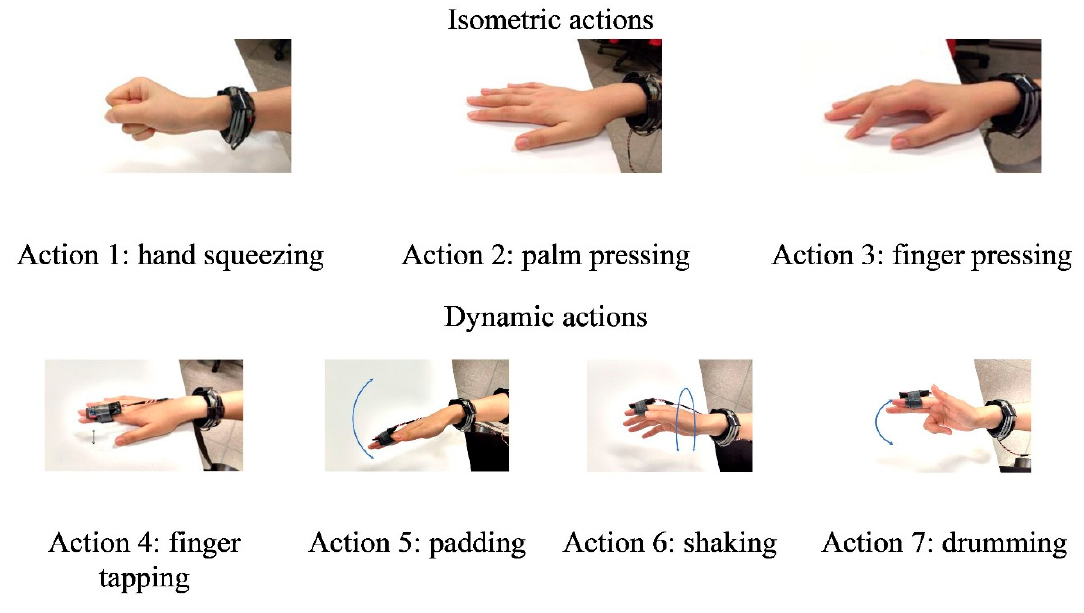
Figure 4. Selected hand actions.